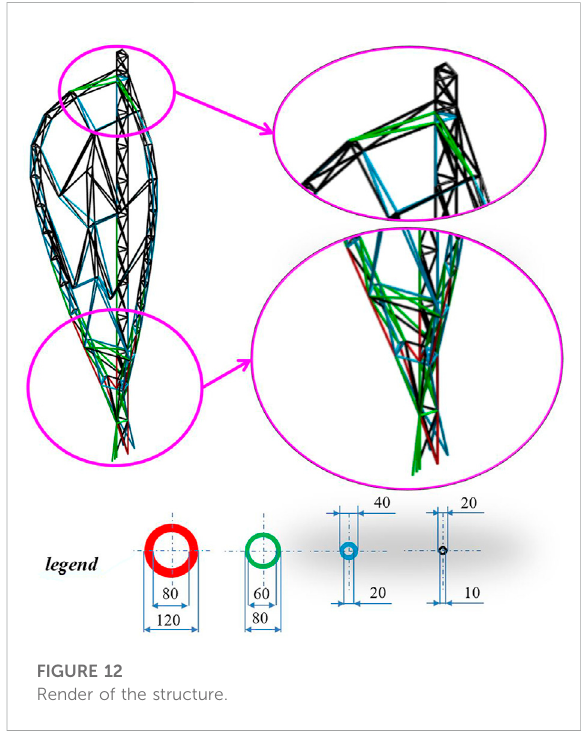
FIGURE 12 Render of the structure.